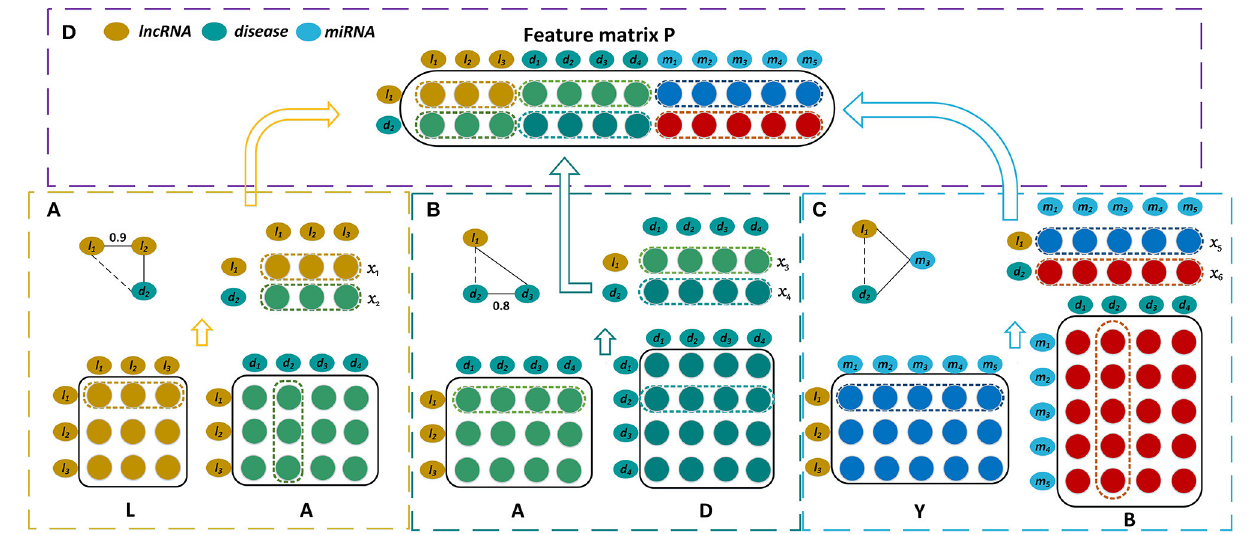
Frontiers in Genetics |